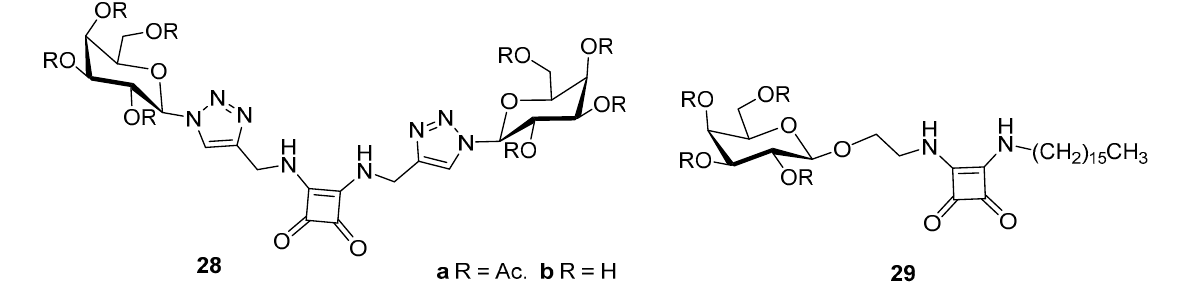
Figure 20. Structures of novel glycosyl squaramide supramolecular gelators [63] .